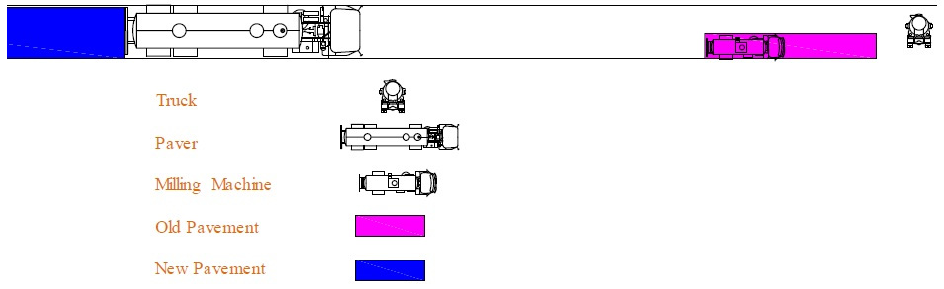
Figure 3. Pavement rehabilitation production line [92]. Table 4. Comparison of goals in asphalt mixture construction.